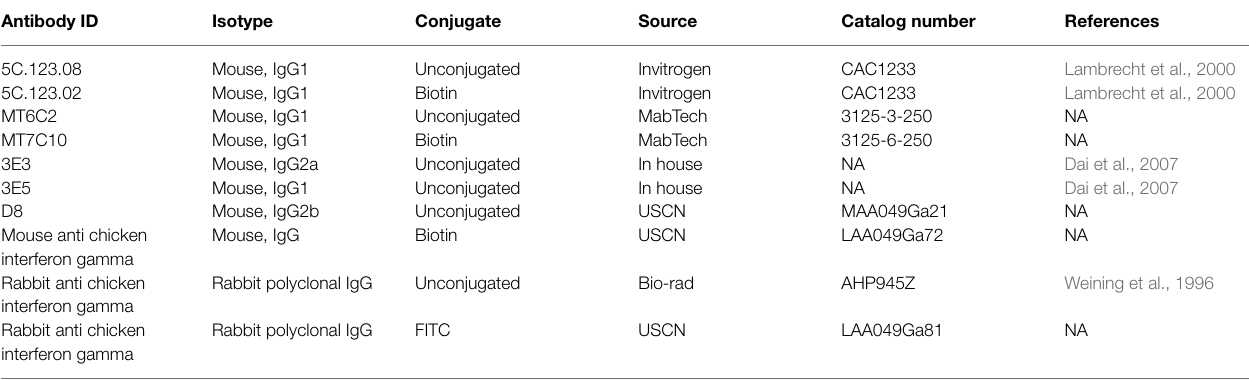
TABLE 3 | Chicken IFN- γ antibodies tested in intracellular cytokine staining (ICS)